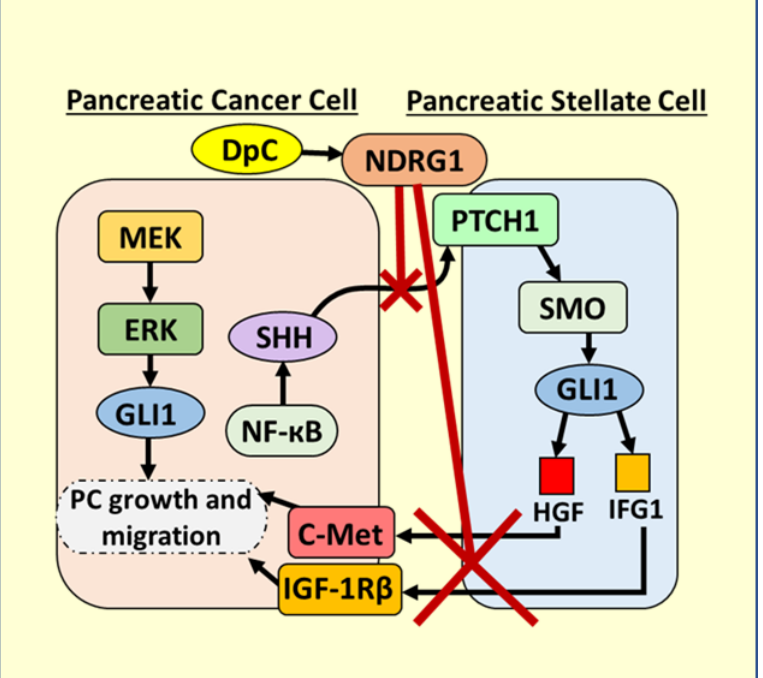
Figure 11. Targeting oncogenic Sonic Hedgehog signaling between PC cells and PSCs via NDRG1 induced by DpC. Pancreatic cancer (PC) cells have an abnormal NF-kB activation, which stimulates the production of Sonic Hedgehog (SHH). The secreted SHH binds to the PTCH1 membrane receptor on pancreatic stellate cells (PSCs). The binding of SHH to PTCH1 leads to the activation of the smoothened (SMO) receptor in PSCs that subsequently activates GLI1. GLI1 promotes HGF and IGF-1 transcription in PSCs, which are secreted and bind to c-Met and IGF-1R β receptors on PC cells, promoting their growth and migration. HGF and IGF-1 further stimulate SHH production, establishing bidirectional crosstalk between PSCs and PC cells. It was found that the DpC-induced upregulation of NDRG1 potently inhibits this bidirectional crosstalk by inhibiting SHH production by PC cells, preventing the activation of PSCs to secrete HGF and